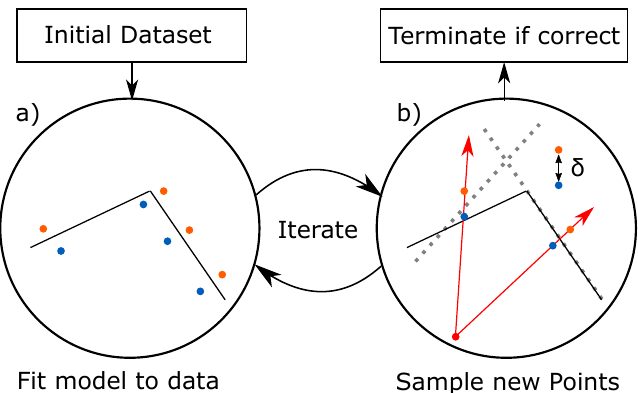
Figure 2: Graphical depiction of the algorithm for a double dot system. Starting with an initial dataset, the algorithm repeats steps a) and b) until termination. a) Algorithm fits model (black lines) to separate points inside the target state (blue) and outside (orange). b) Line-searches are performed from a common starting point (red dot) in the direction of a point of each facet of the model (red arrows). Line-searches produces new pairs of samples (orange / blue dots) with the true boundary (dotted lines) in-between. The distance between red and blue dots is smaller than δ . See text for more